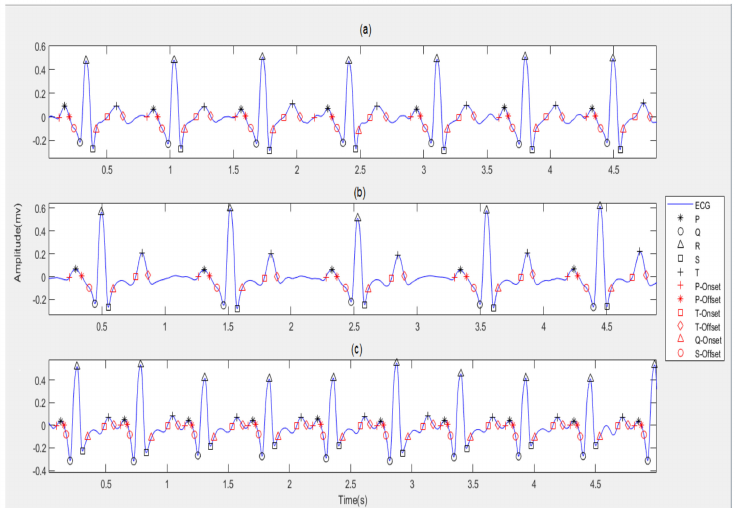
Figure 4. The peaks and intervals detection for ECG types: ( a ) The Normal ECG; ( b ) The Bradycardia ECG; ( c ) The Tachycardia